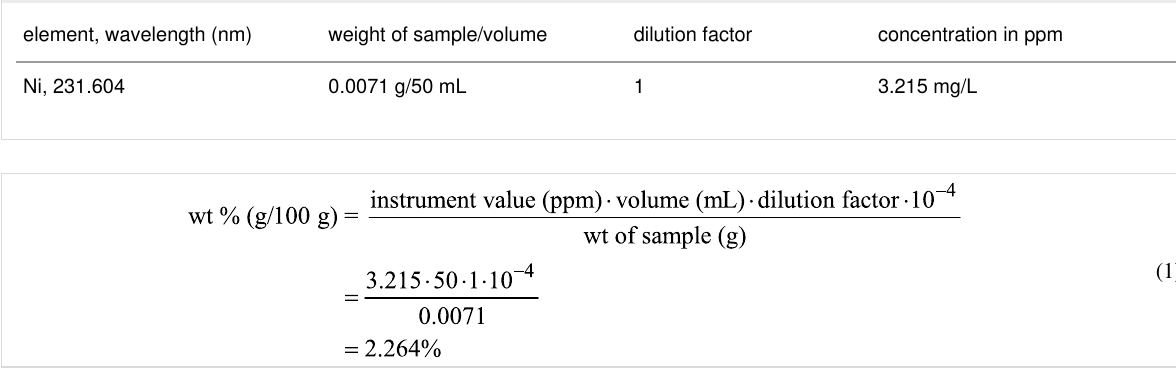
Table 1: ICP–OES analysis of the Ni–chitosan NPs. element, wavelength